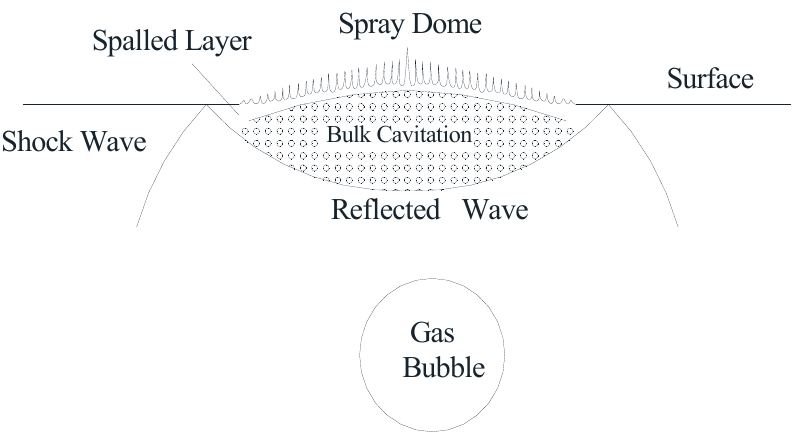
Figure 6. Surface spalling by an underwater explosion.